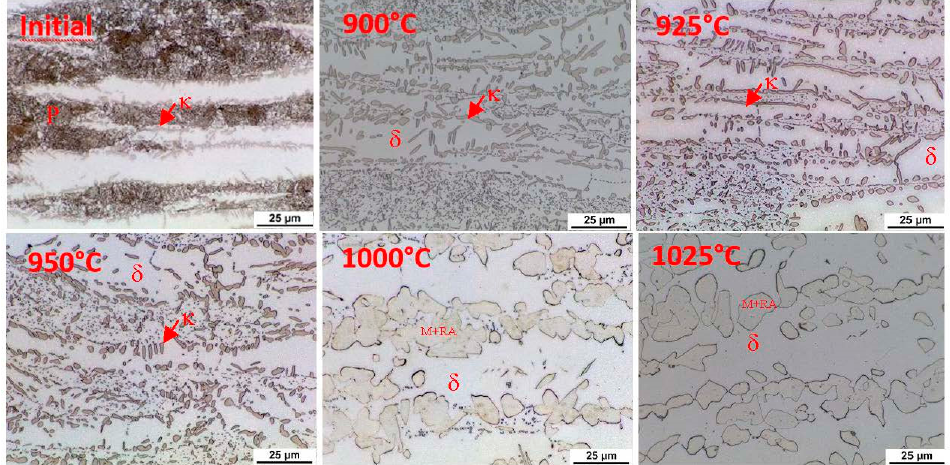
Figure 13. Microstructure of the initial state after different austenitisation temperatures, heat C with 7 wt% Al. P—pearlite, δ —ferrite, γ —austenite, κ —kappa phase.